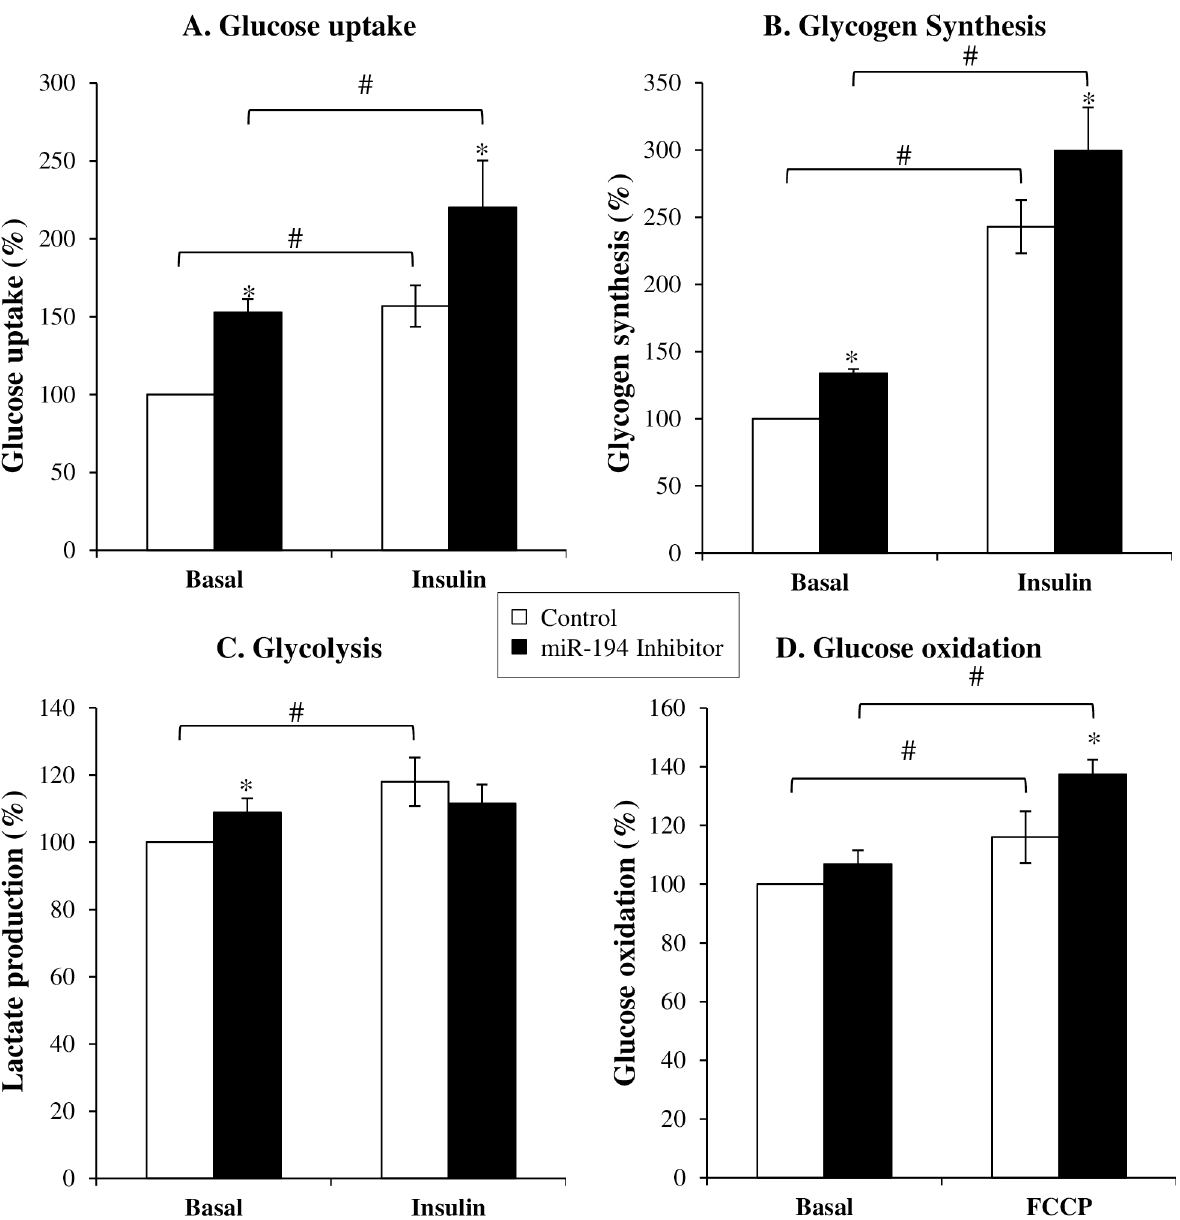
Fig 3. Effect of miR-194 inhibition on glucose homeostasis in L6 cells. Basal or insulin-stimulated glucose uptake (A), glycogen synthesis (B) and lactate production (C) were assayed in L6 cells 48 hours after transfection with a miR-194 inhibitor. Glucose oxidation (D) was also measured in these transfected cells under basal conditions or after treatment with the mitochondrial uncoupler FCCP. Values are expressed as mean ± SEM of 4 – 6 individual experiments, with 4 technical replicates. P -values were determined using 2-way ANOVA (normally distributed data) or Kruskal-Wallis 1-way ANOVA on ranks (non-normally distributed data) followed by Student- Newman-Keuls post-hoc tests ( * p < 0.05 vs. control, # p < 0.05 vs.